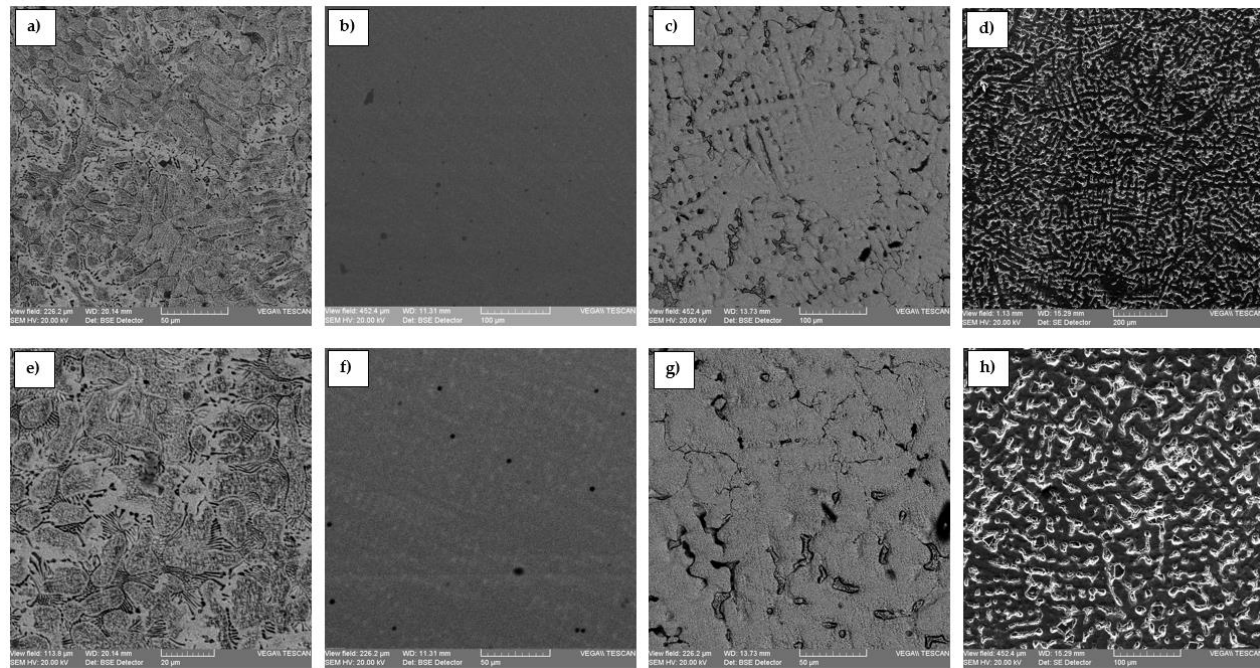
Figure 4. Microstructure analysis of experimental alloys: ( a ) VeraBond (200×), ( b ) Keran N (200×), ( c ) VeraSoft (200×), ( d ) VeraSoft modified (200×) ( e ) VeraBond (500×), ( f ) Kera N (500×), ( g ) VeraSoft (500×), ( h ) VeraSoft modified (500×).